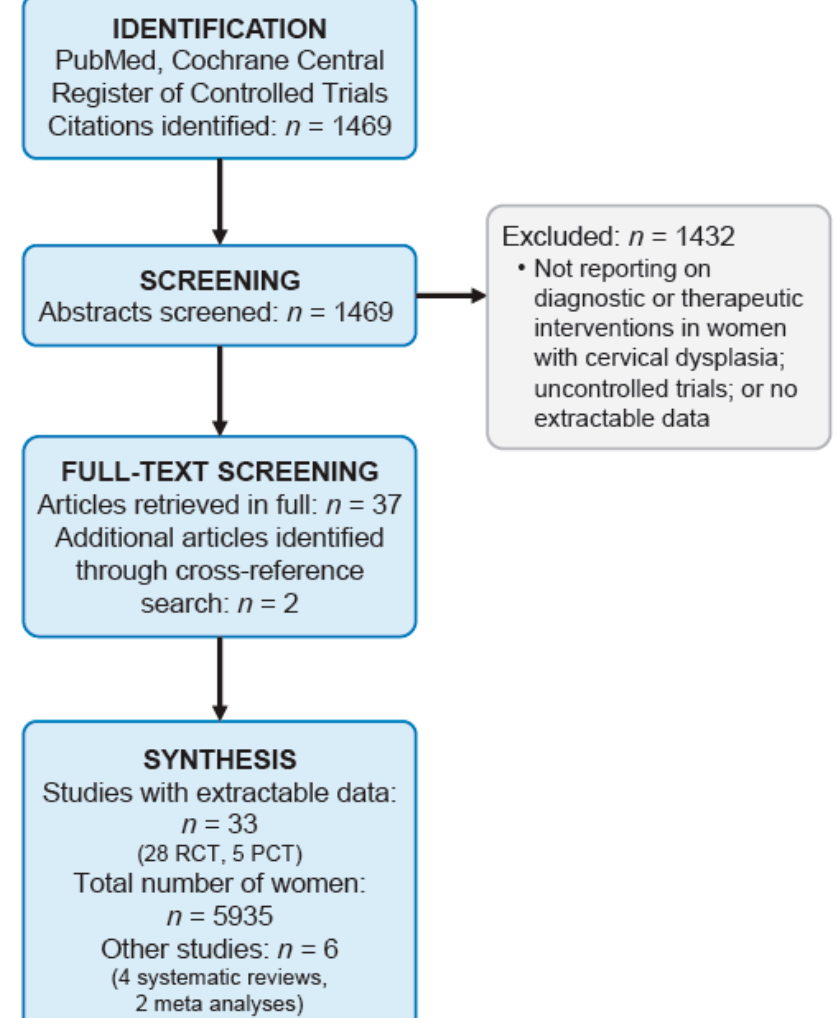
Figure 1. Flow diagram of the literature search algorithm.